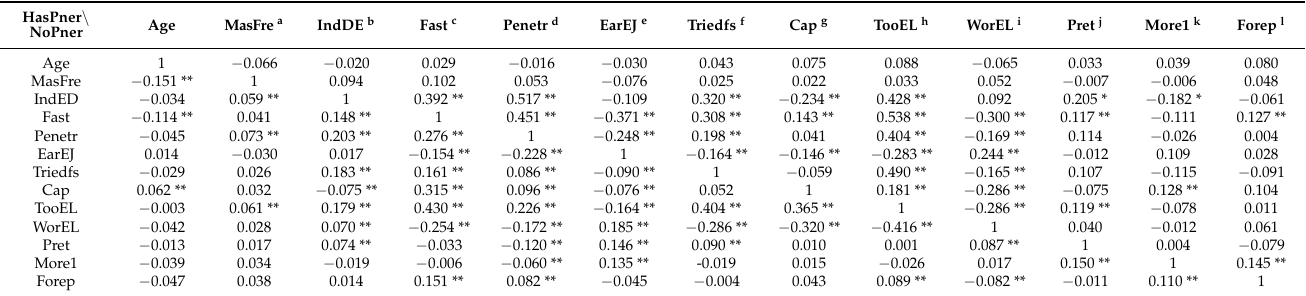
Table 4. Correlations between Age, Masturbation Frequency, Overall Indication for Delayed Ejacula- tion, and Ejaculation Problems in men who have a partner (in the below diagonal) and men who do not have a partner (in the above